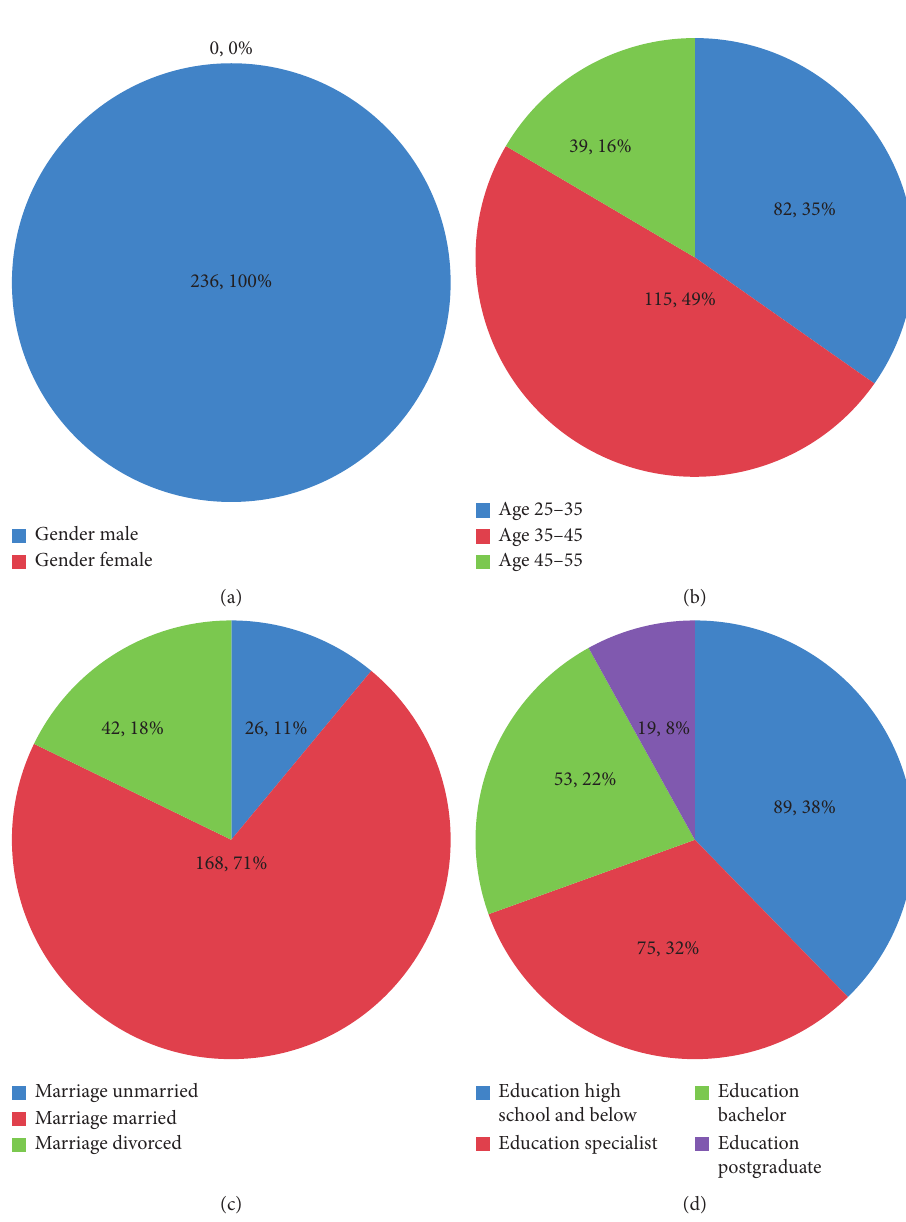
Figure 5: Basic situation of